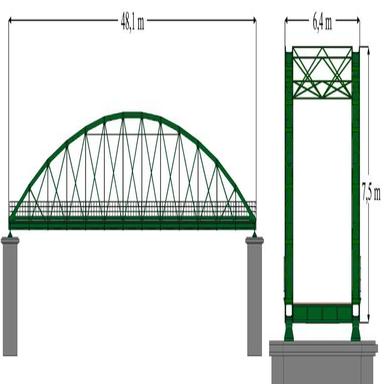
O Barqueiro Bridge: (a) lateral view and (b) cross-section.